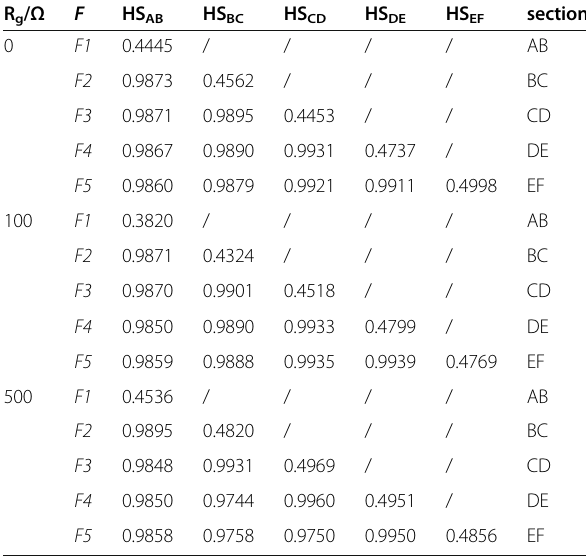
Table 4 Results of the proposed positioning method ( φ = 0 ∘ ,